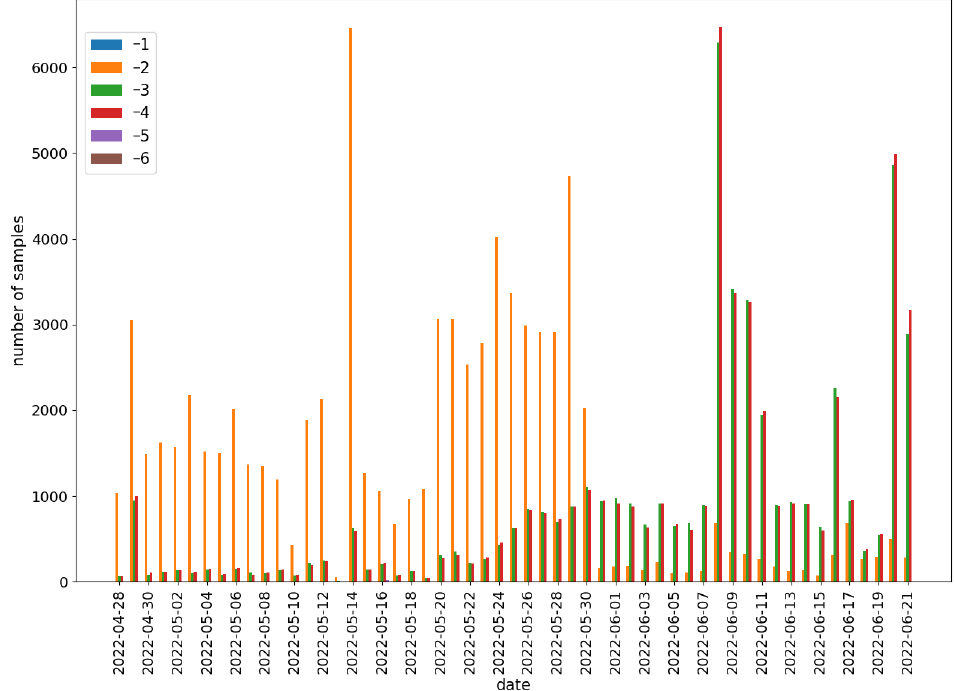
Figure 8. Labeled malicious data distribution in Koodous from the 28 April to the 21